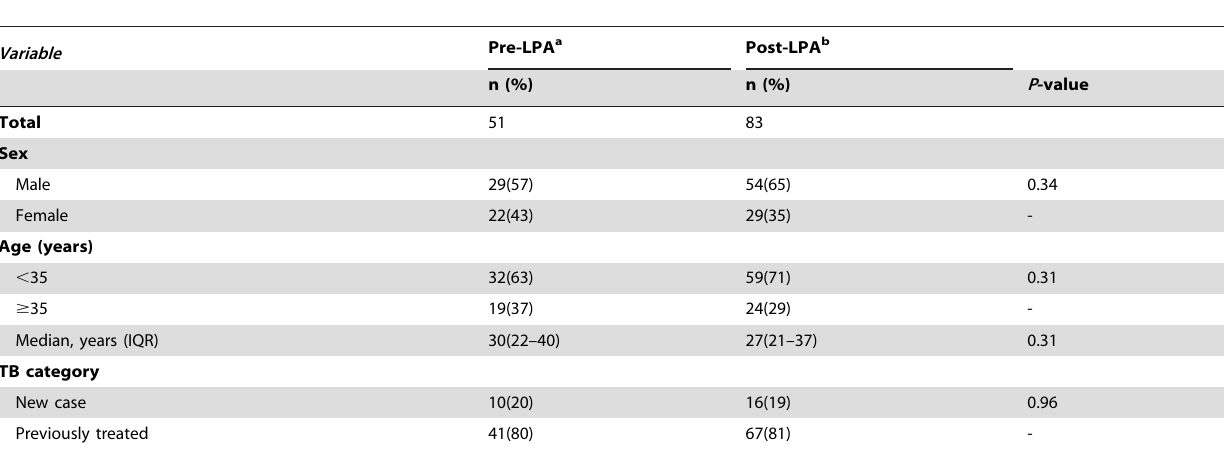
Table 1. Demographic characteristics of MDR-TB patients according to the method of MDR-TB diagnosis used between 2009– 2012 - New Delhi,